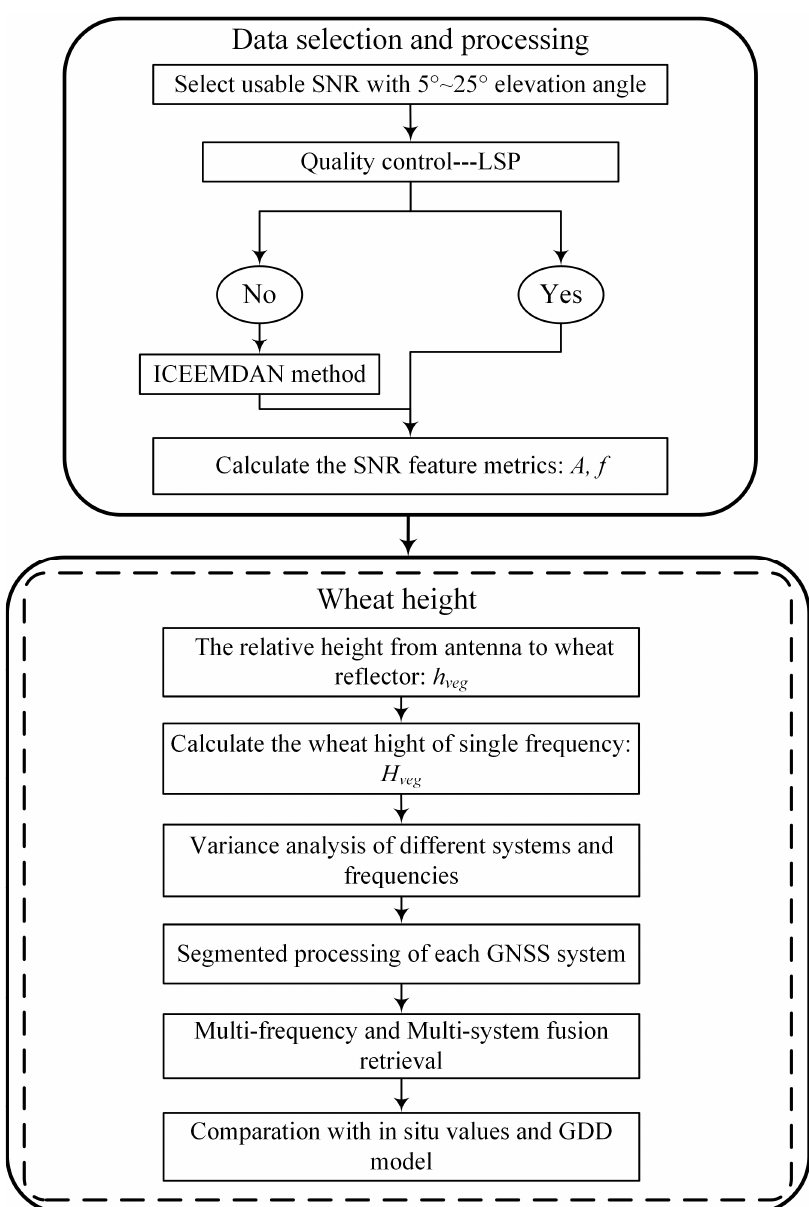
Figure 4. Flowchart of the algorithm retrieval process.